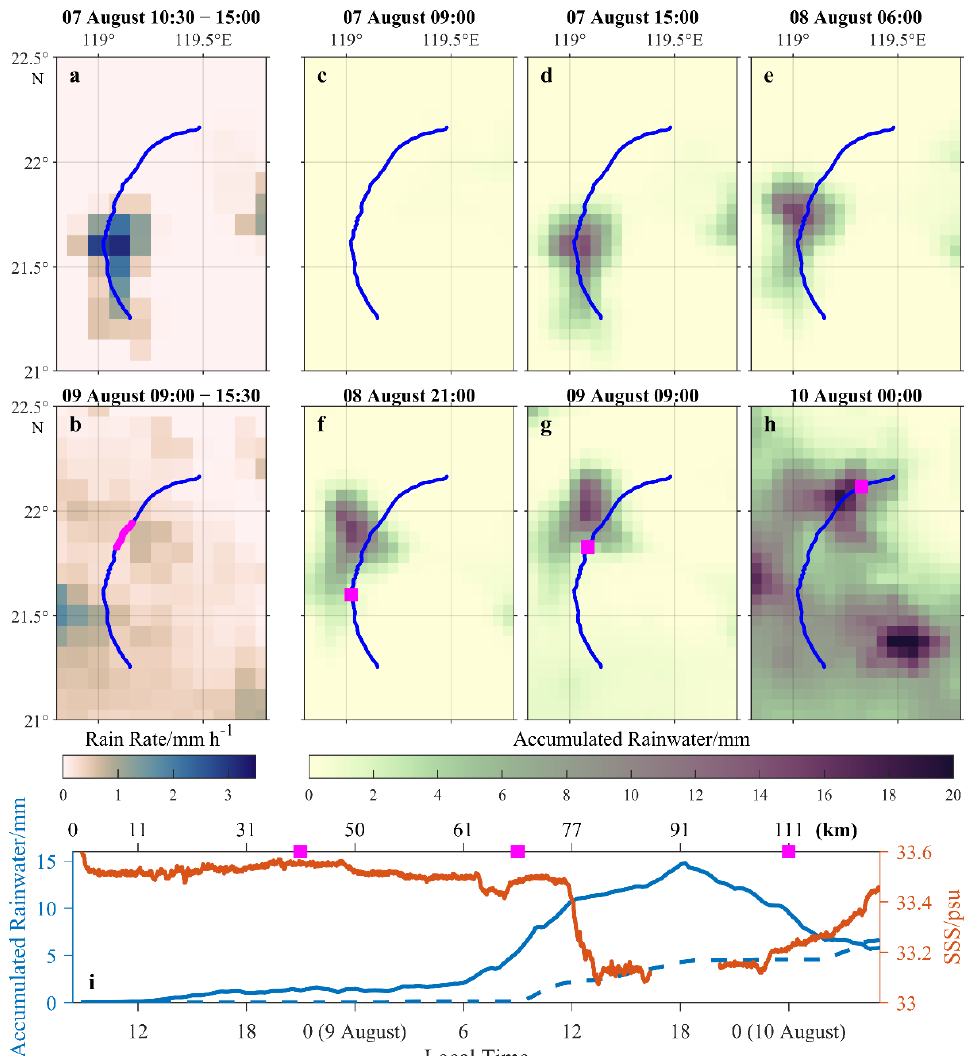
Figure 4. ( a , b ) The mean rain rate based on GPM data during the two rainfall events. The magenta lines indicate the R/V track during the rain periods. ( c – h ) R PTS in different times. The magenta squares indicate the position of the R/V. ( i ) R PTS·ship (blue solid lines) and R local (blue dash lines). Red lines indicate the sea surface salinity from SBE-21. The blue curve in ( a – h ) indicates the R/V track during the observation. The magenta squares in ( i ) indicate the same time as in ( f – h ).